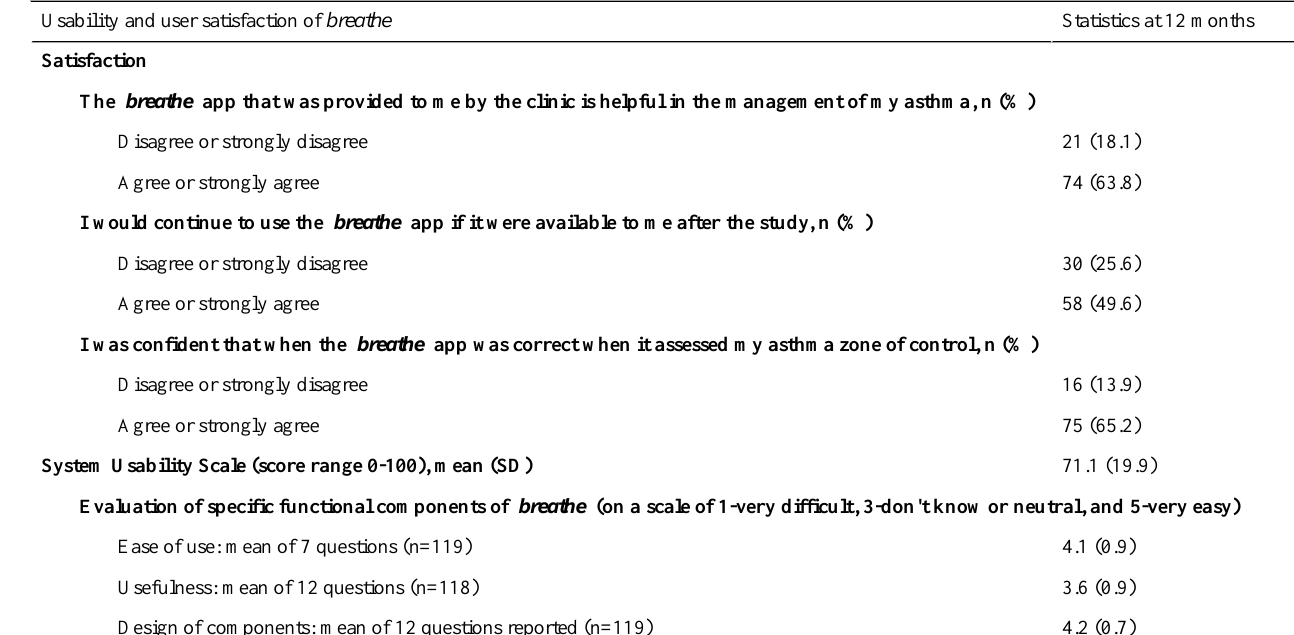
Table 1. Usability